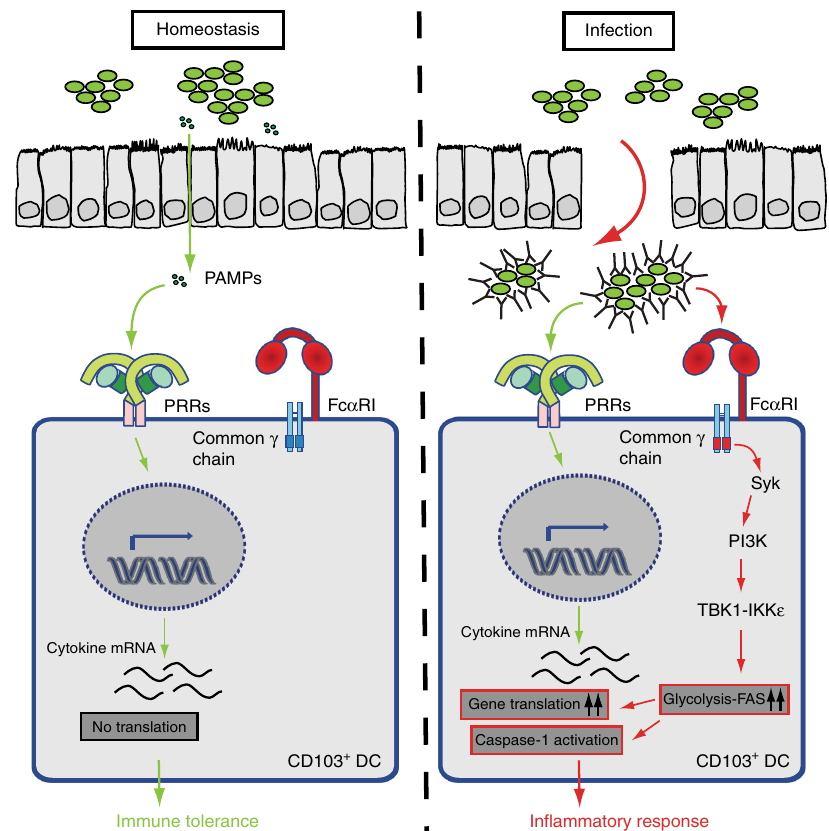
Fig. 7 Model for in fl ammatory response upon Fc α RI-TLR cross-talk. Under homeostatic conditions CD103 + dendritic cells (DC) are activated by pathogen- associated molecular patterns (PAMP) through leakage or sampling of the lumen. This induces in fl ammatory cytokine mRNA transcription, but no protein production. Upon infection, IgA immune complexes (IgA-IC) provide a second signal through Fc α RI triggering Syk, PI3K, and TBK1-IKK ε activation, which increases the glycolytic fl ux and fatty acid synthesis (FAS) that results in an in fl ammatory response mediated by increased mRNA translation and